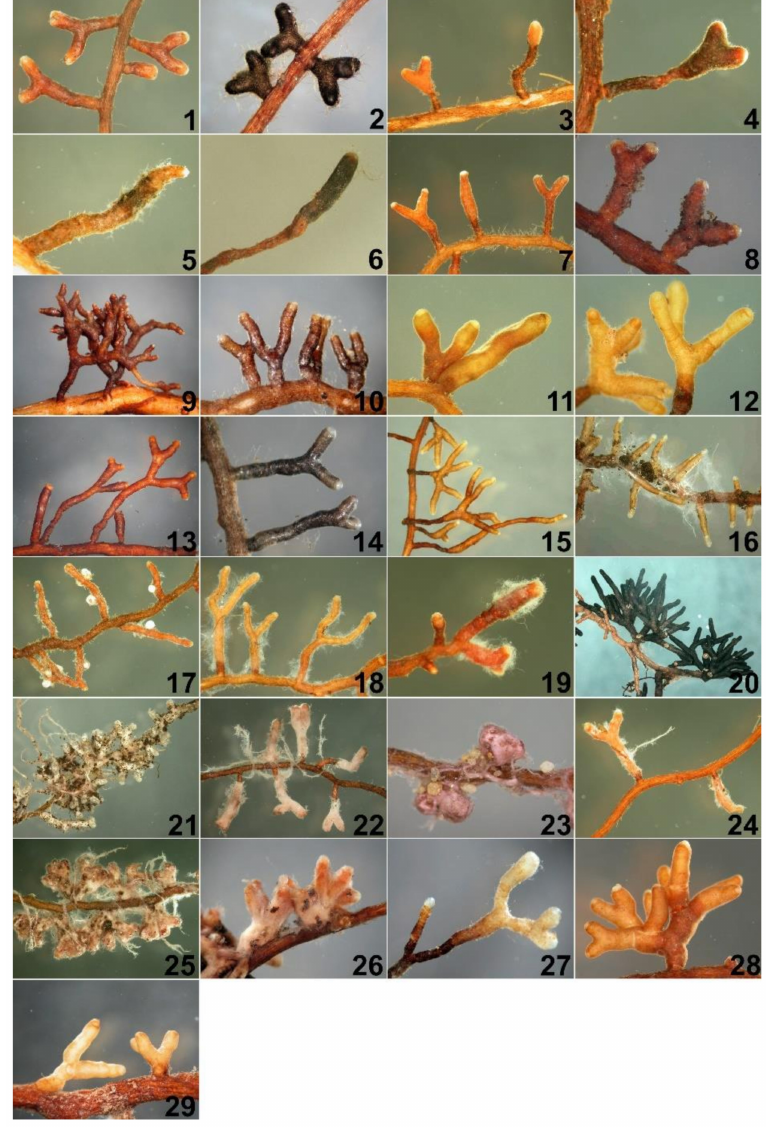
Figure 1. Plan views of mycorrhizas observed on 1- and 2-year-old Scots pine seedlings from bare- root forest nurseries: 1— Wilcoxina mikolae ; 2— Cenococcum geophilum ; 3— Tuber puberulum ; 4— Tuber rufum ; 5— Meliniomyces bicolor ; 6— Cadophora finlandica ; 7— Peziza sp.; 8—Pyrenomycetaceae; 9— Ascomycetes; 10—Pezizaceae 1; 11— Tuber sp. 1; 12— Tuber sp. 2; 13— Pustularia sp.; 14—Pezizaceae 2; 15— Thelephora terrestris ; 16— Hebeloma crustuliniforme ; 17— Hebeloma sacchariolens ; 18— Hebeloma velutipes ; 19— Amphinema byssoides ; 20— Tomentella sp.; 21— Suillus luteus ; 22— Suillus bovinus ; 23— Suillus variegatus ; 24— Suillus granulatus ; 25— Rhizopogon roseolus ; 26— Rhizopogon luteolus ; 27— Inocybe sp.; 28— Laccaria laccata ; 29— Laccaria